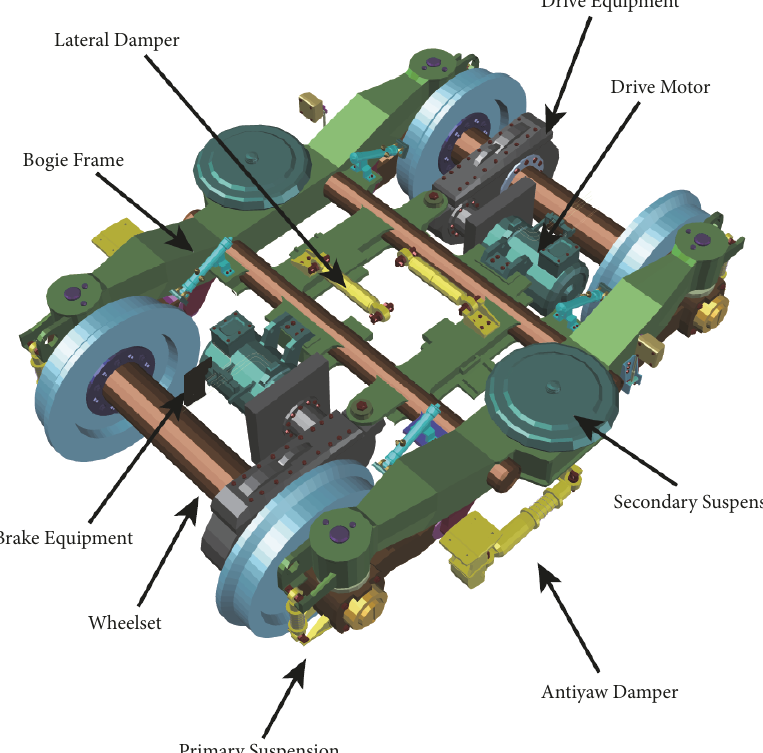
Figure 1: Structure of the